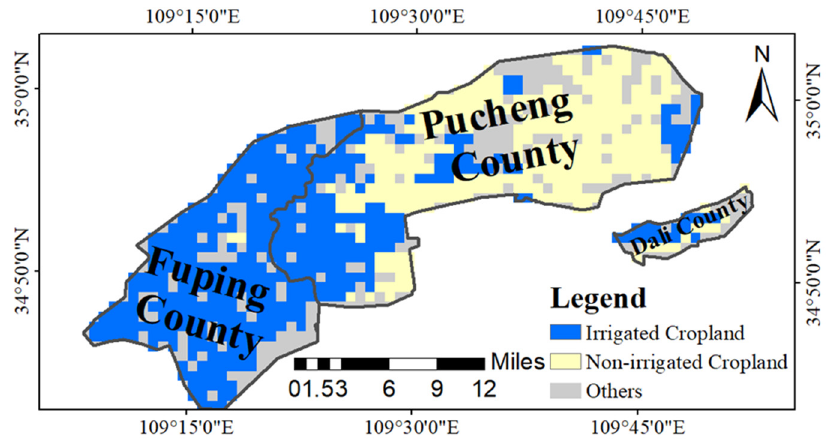
Figure 11. Spatial distribution map of the precipitation on 8 March 2018.